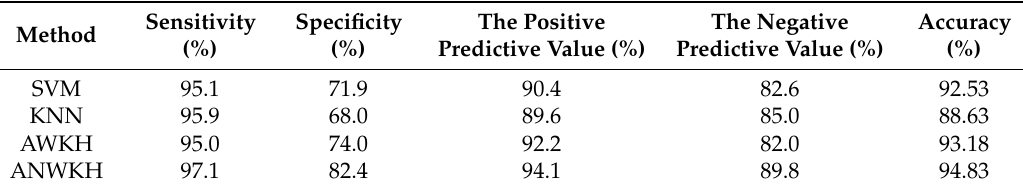
Table 4. The average results of random classification for ANWKH, AWKH, HKNN, and